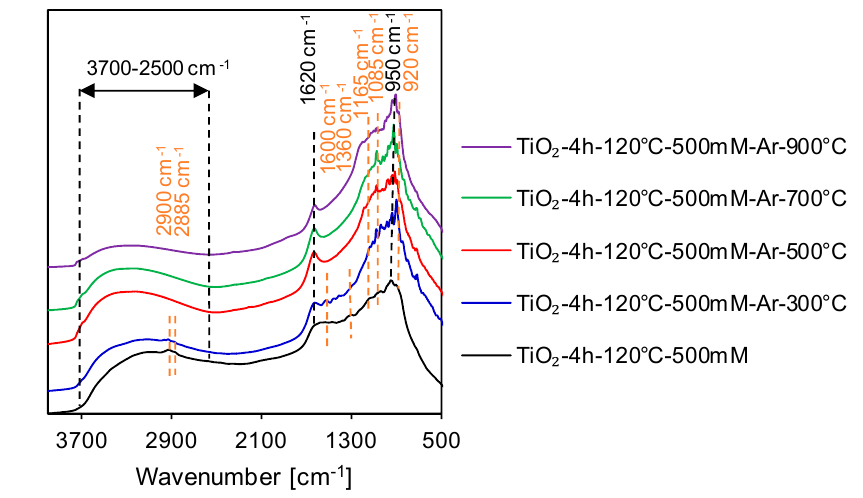
Figure 3. Diffuse refletrance Fourier transform infrared spectra (DRIFTS) of and APTES-modified TiO 2 before and after calcination process.